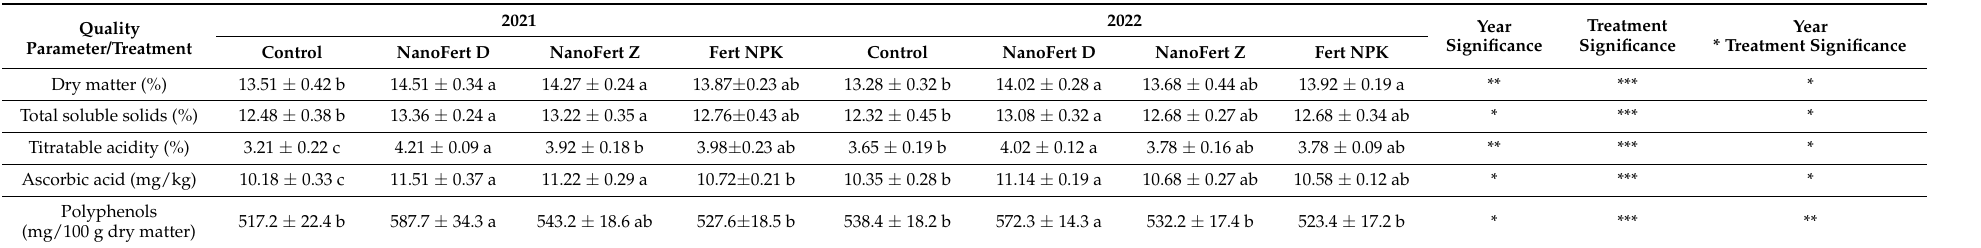
Table 7. The effect on apple fruit quality characteristics of the experimental treatment with foliar fertilizers and foliar fertilizers with particle film-forming SNNMs. Orchard of “Vasili Adamachi” experimental farm, Faculty of Horticulture, “Ion Ionescu de la Brad”, Iasi University of Life